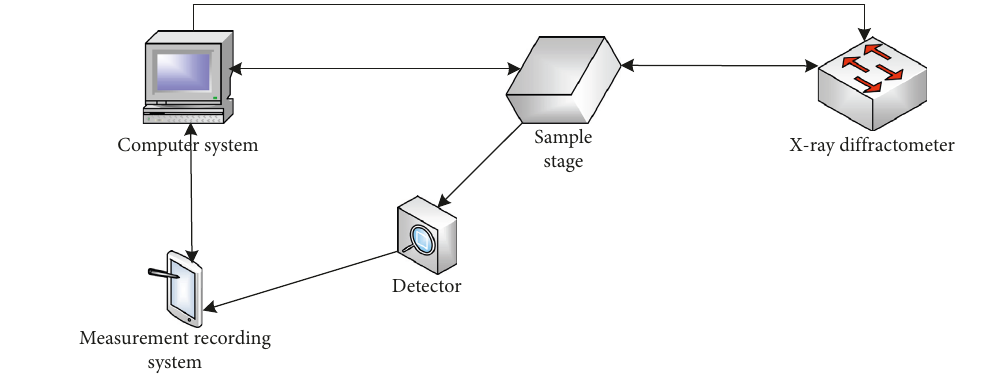
Figure 4: Basic structure of X-ray diffractometer.